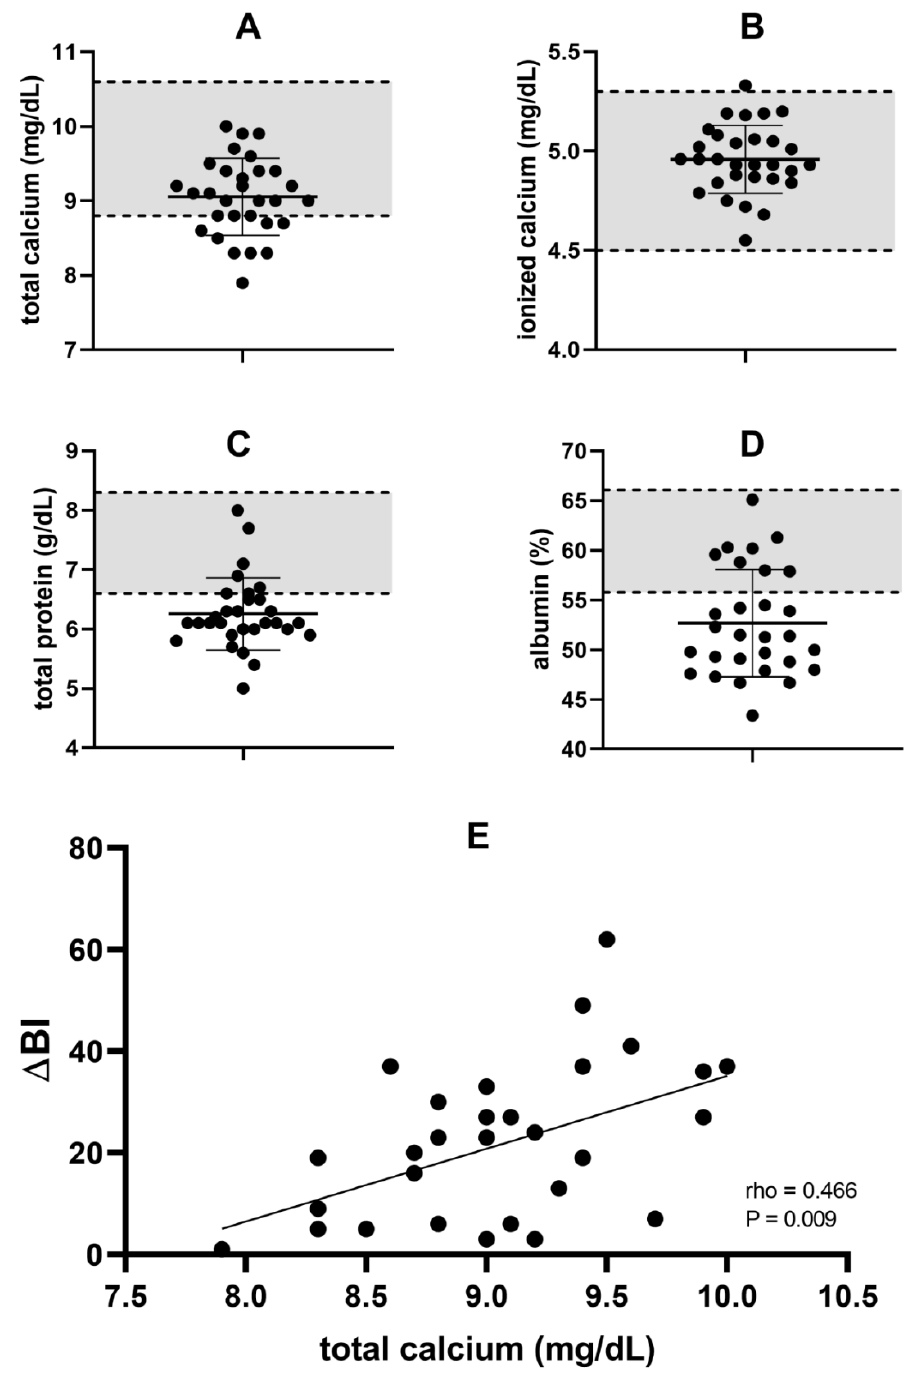
Figure 1. Dot plots (with mean values and error bars) of ( A ) total calcium, ( B ) ionized calcium, ( C ) total protein, and ( D ) albumin percentage. Reference ranges are identified by grey areas enclosed by dashed lines. ( E ) Scatterplot of the change from baseline of the Barthel Index (ΔBI) after 6 weeks of treatment versus the total calcium at baseline (rho = Spearman’s rank-order correlation coefficient).